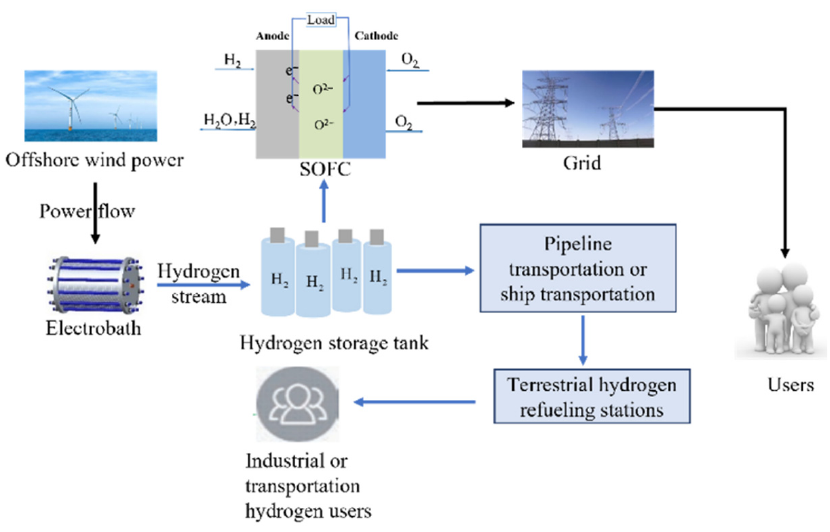
Figure 1. Block diagram of offshore wind SOFC system structure.